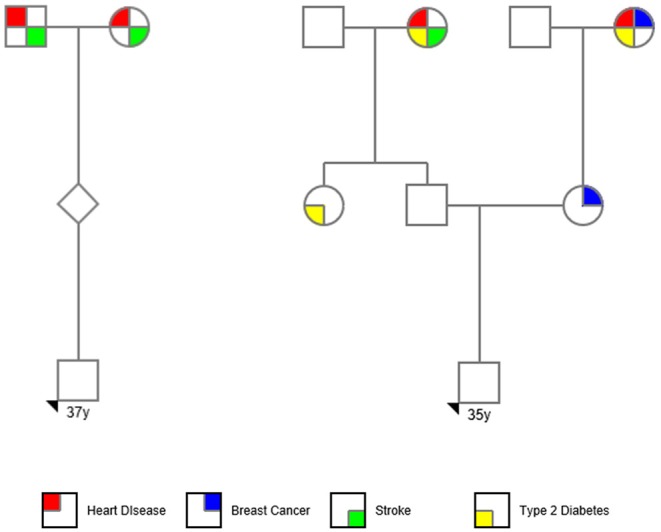
PGT-P case pedigree.